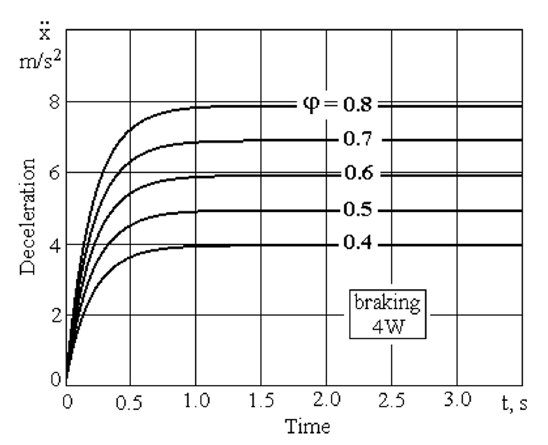
Figure 5. Variation of tractor speed during braking taking into ac- count the time, for 5 values of the coefficient of road ad- hesion - braking applied on all